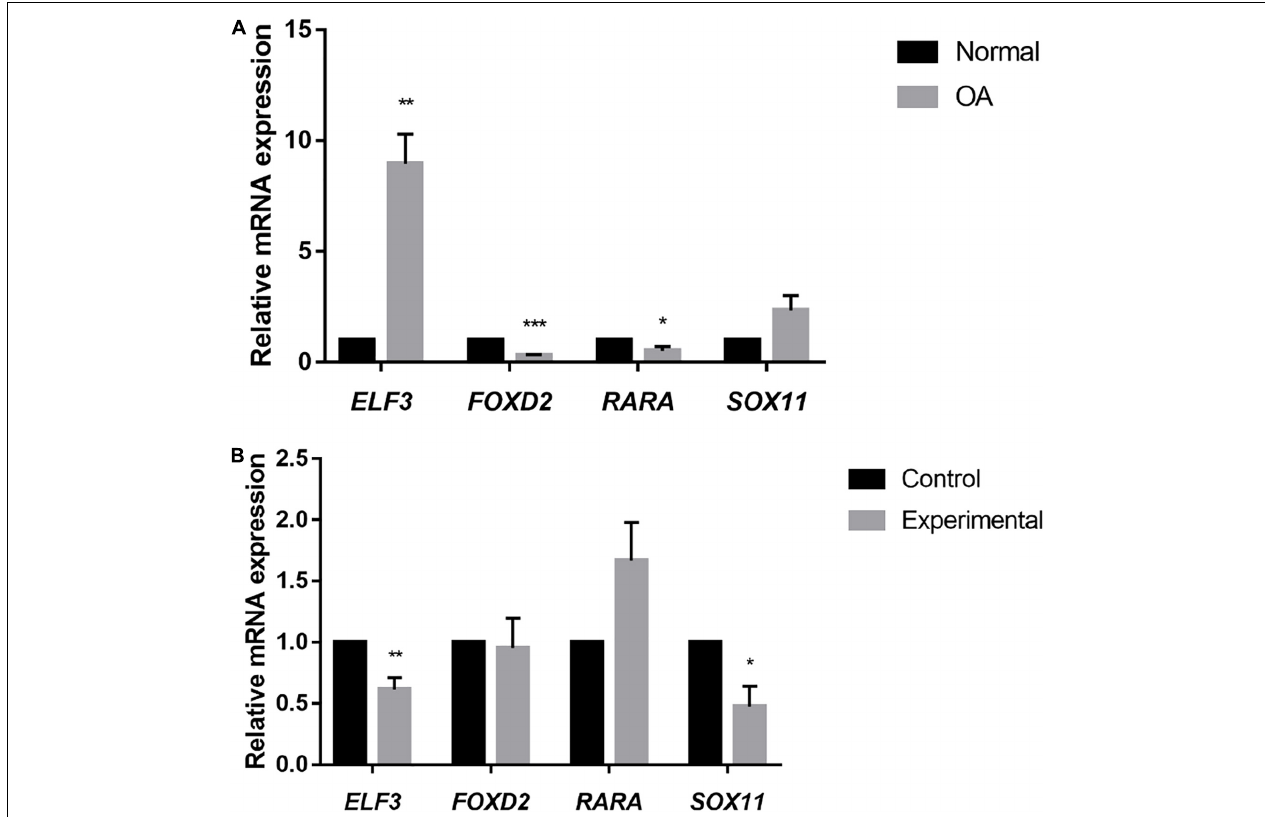
FIGURE 4 | (A) Relative mRNA expression of selected TFs in normal and OA knee articular cartilage, assessed by RT-qPCR. * P < 0.05, ** P < 0.01, *** P < 0.001. (B) Relative mRNA expression of selected TFs in cultured primary human chondrocytes ( N = 3) treated with 5-Aza (10 µ M) or vehicle for 4 days. Values are expressed as mean ± SEM. * P < 0.05, ** P < 0.01, *** P <